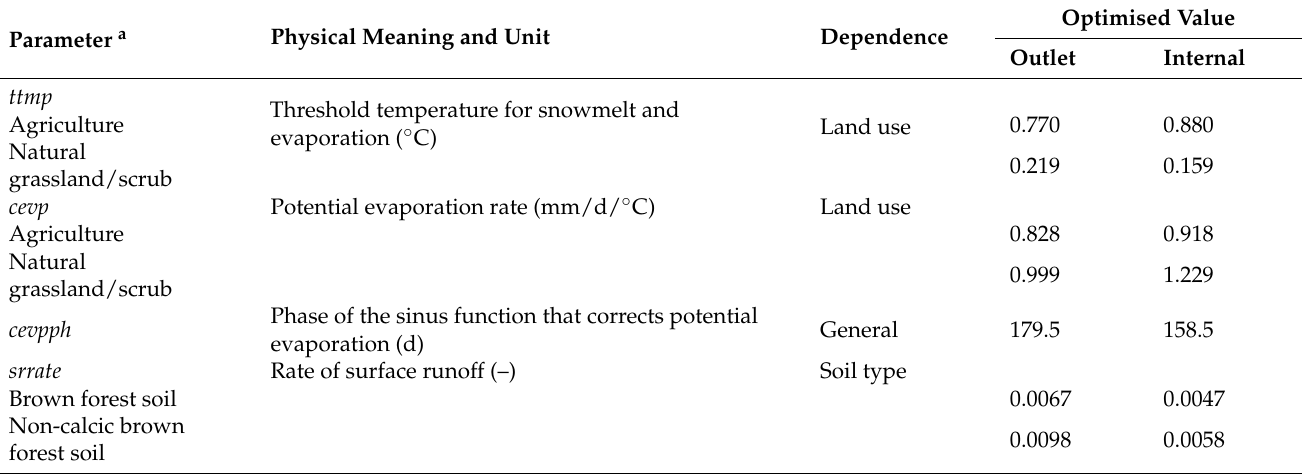
Table 3. The HYPE model’s best-optimised parameters for the Alata River Basin (ARB) outlet and internal gauging stations. Parameter